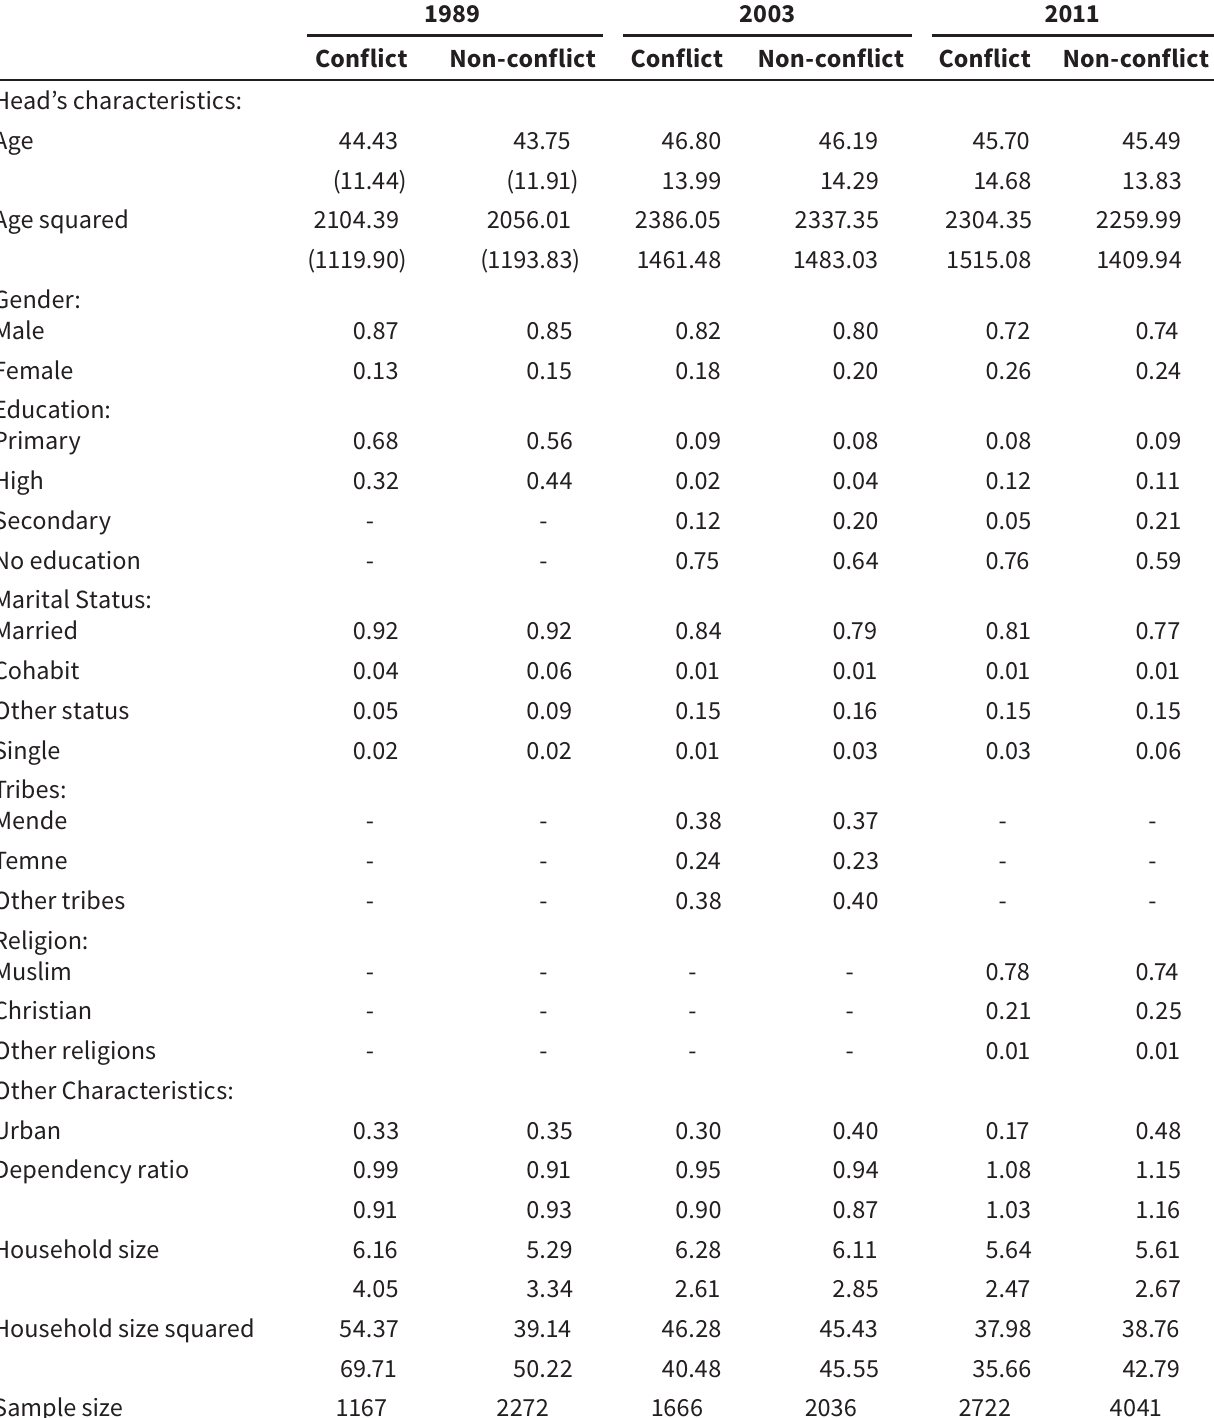
Table 5 Summary Statistics of Household Characteristics by Conflict Exposure